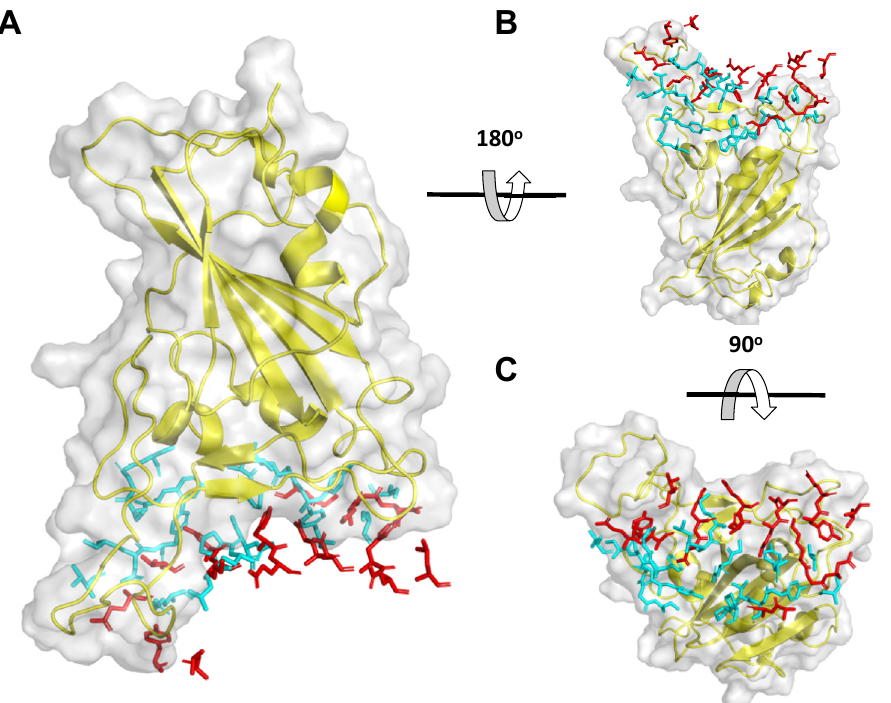
Figure 5. Overlap between ACE2 and mAb CB6 and RBD interfaces. RBD of SARS-CoV-2 S protein is shown in cartoon and surface representation (yellow) while the side chain of the interface residues of ACE2 and mAb CB6 are show in sticks representation in red and cyan respectively. Note that only the interface residues are shown to facilitate the visualization. Panels ( A – C ) show different orientations by applying the rotations shown.